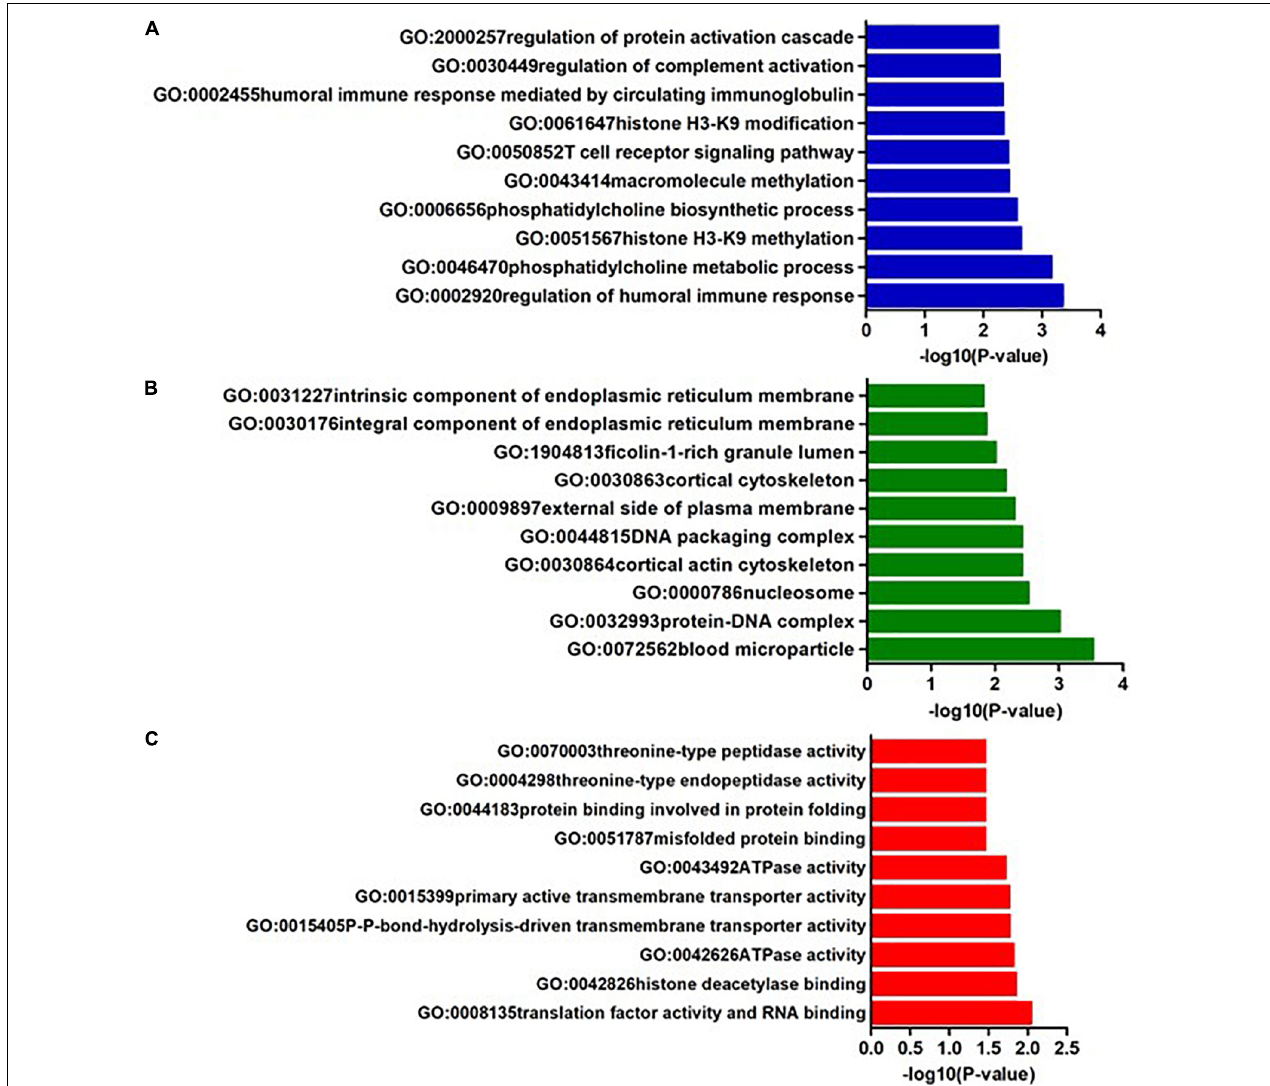
FIGURE 4 | The top ten GO annotations of AQP4-positive NMOSD, (A) is for biological process, (B) is for molecular function, and (C) is for cellular